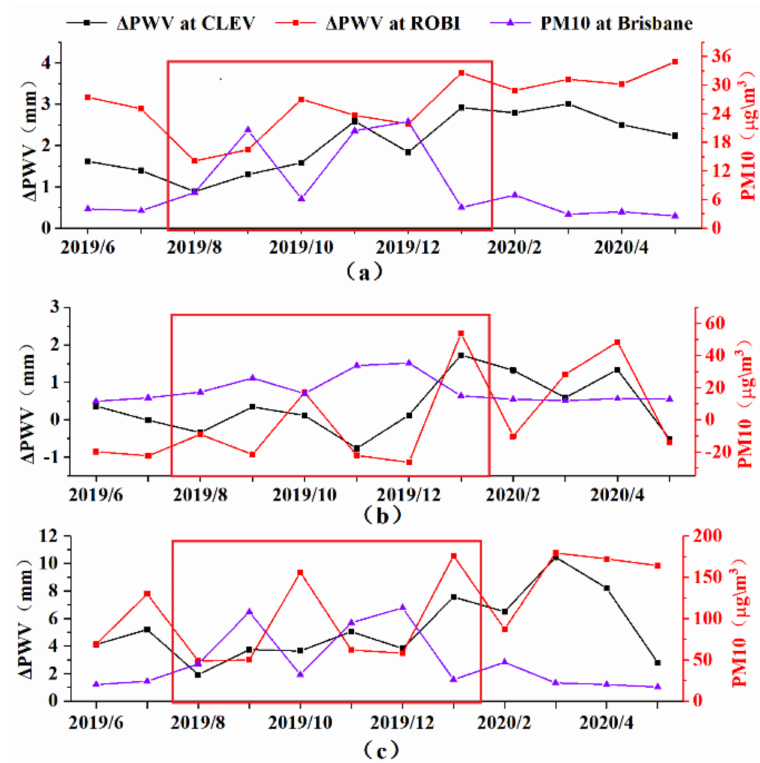
Figure 5. Statistical results of ∆ PWV and PM10 at CLEV and ROBI (( a ) STD statistics, ( b ) MEAN statistics, ( c ) MAX statistics of CLEV and ROBI).